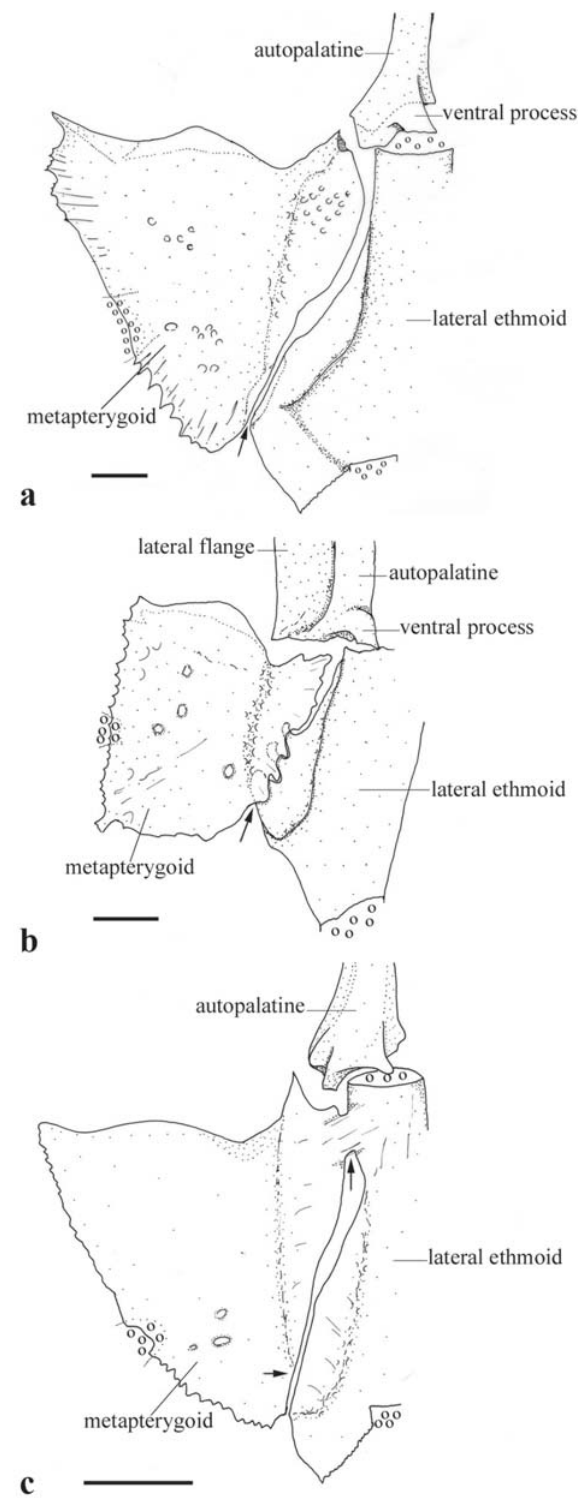
Fig. 18. Ventral view of region of contact between the lateral ethmoid and dorsal border of metapterygoid of Lamontichthys filamentosus (LACM 41741-9, 119.4 mm SL) (a), Rineloricaria sp. (MZUSP 23748, 91.5 mm SL) (b) and Farlowella nattereri (MZUSP 57658, 112.9 mm SL) (c). Arrows points to the region of contact between the two ossifications. Scale bar = 1 mm.